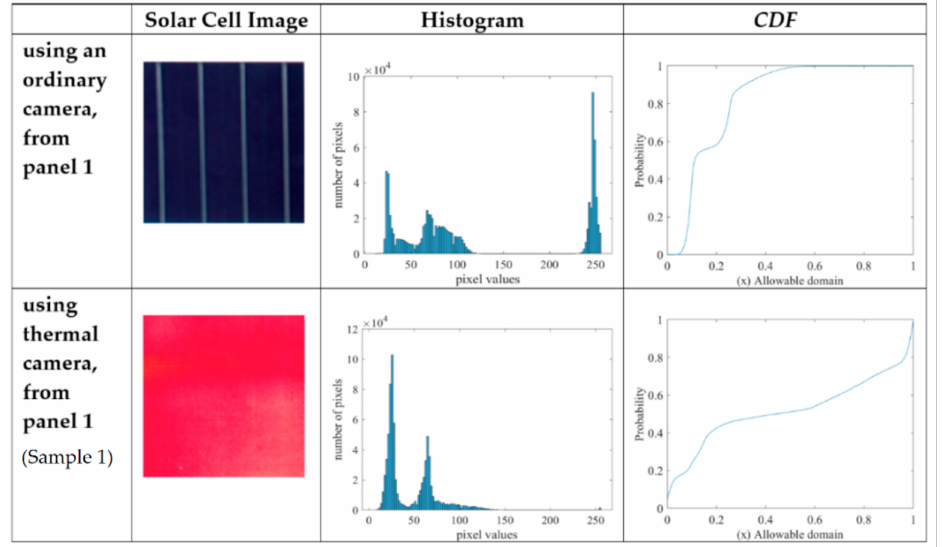
Figure 10. The corresponding histogram and CDF of the solar cell images were taken from ordinary and thermal cameras.